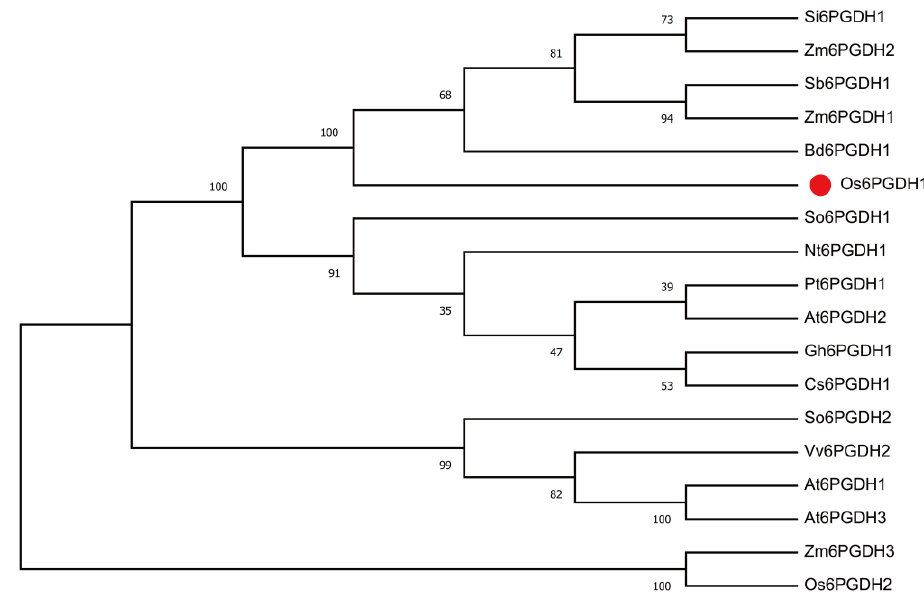
Figure 1. Phylogenetic analysis of 6PGDH proteins from different plant species. The plant species and NCBI accession numbers used in phylogenetic analysis are as follows: Oryza sativa